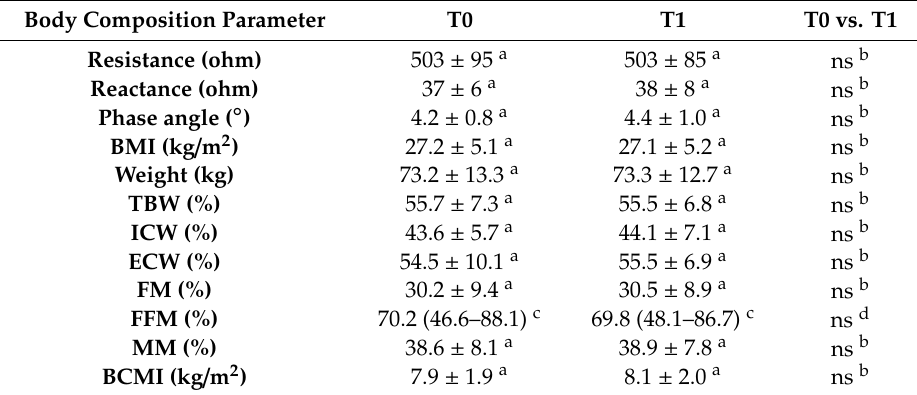
Table 4. Body composition parameters of CKD